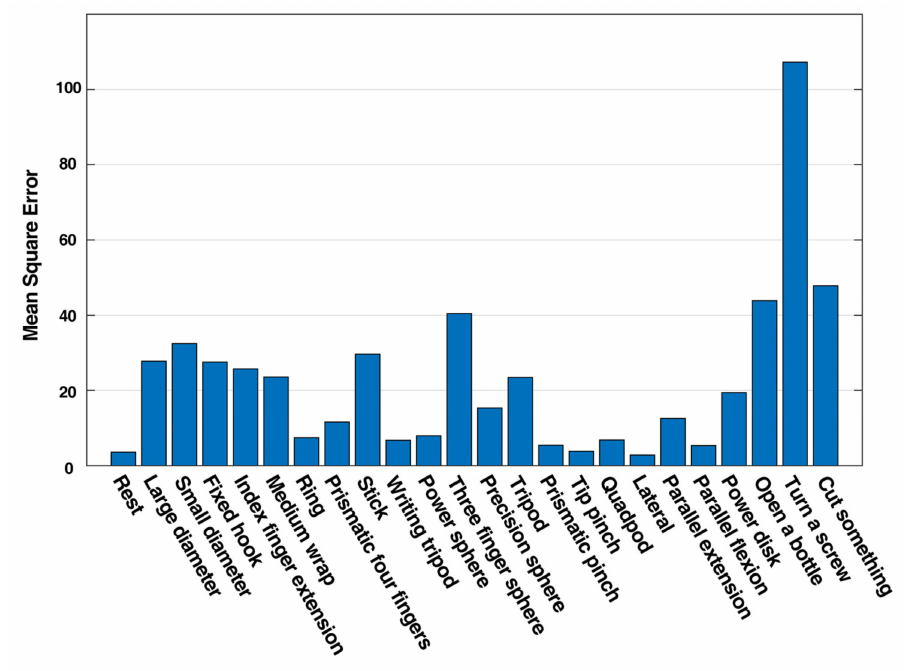
Figure 16. Mean square error of daily functional